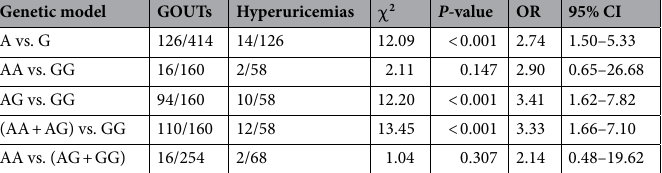
Table 4. Allele and genotype frequencies and genetic model of SNPs rs1718119 in the two